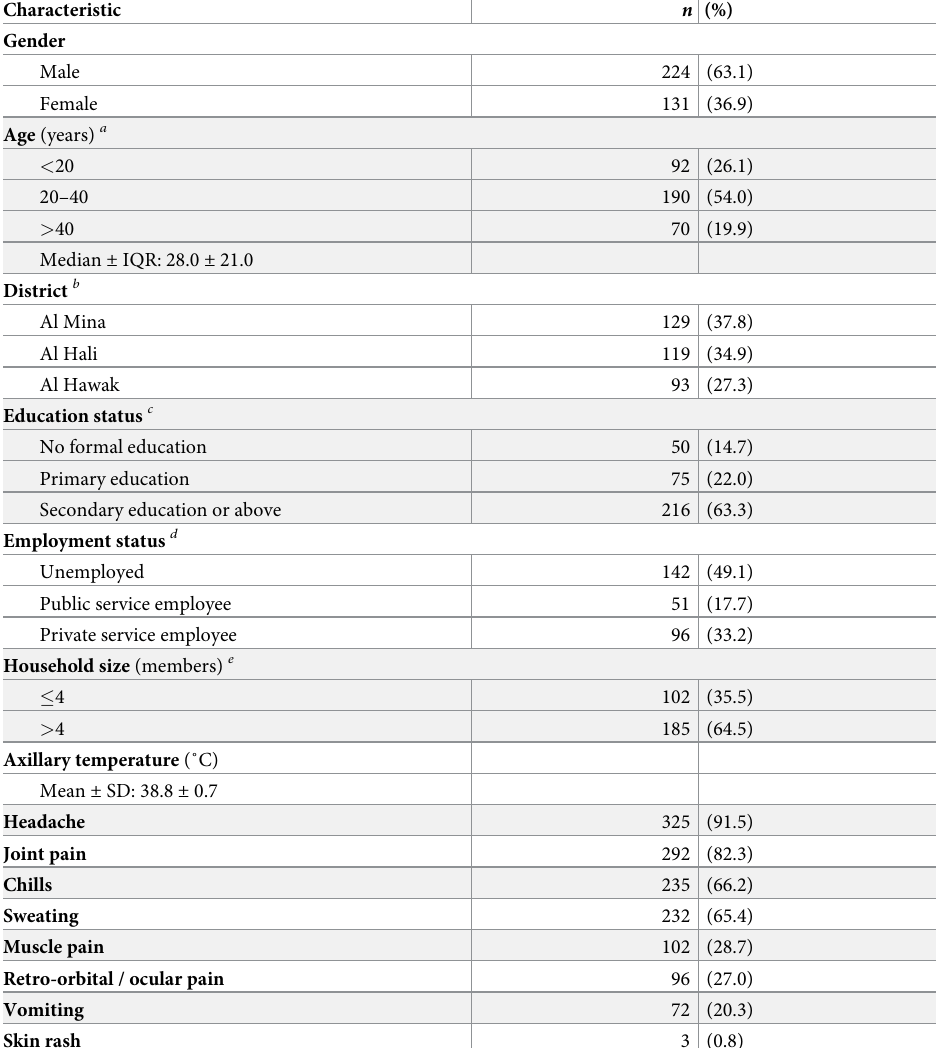
Table 1. Sociodemographic and clinical characteristics of febrile patients attending the outpatient departments in hospitals of Hodeidah city, Yemen (2018–2019) �